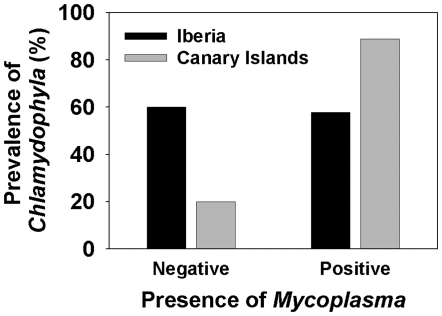
Association between the pathogens Chlamydophila psittaci and Mycoplasma spp. in Canarian Egyptian vulture fledglings.